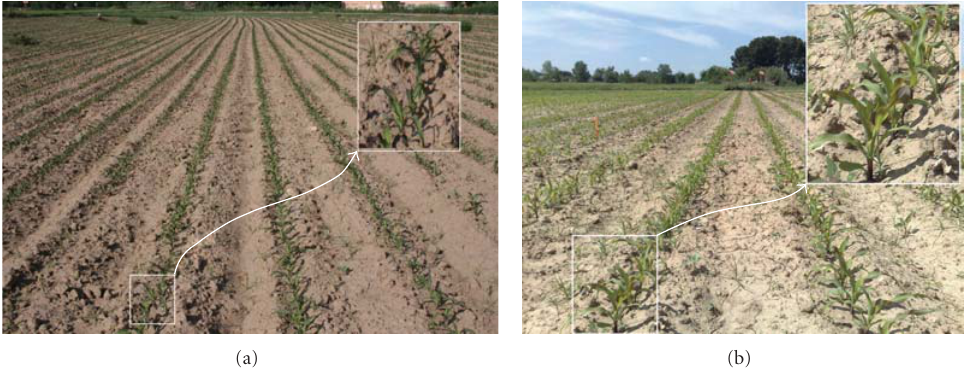
Figure 2: Di ff erent crop growth stages: (a) low; (b) high.